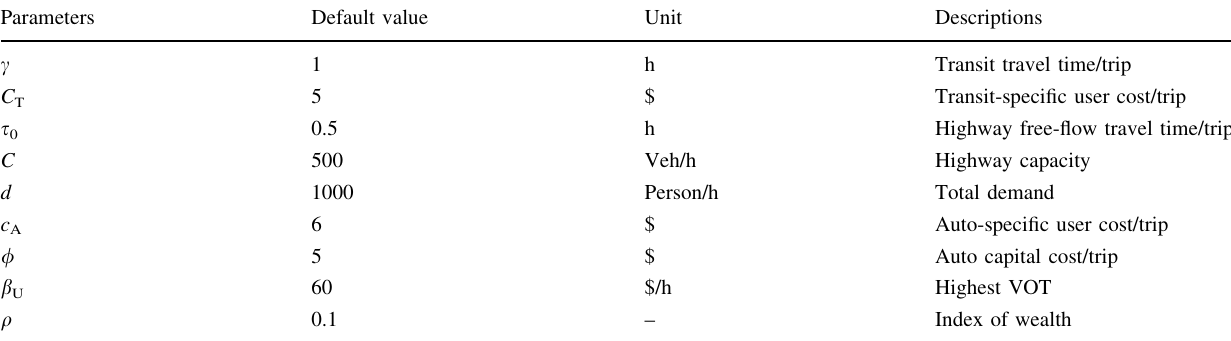
Table 1 Descriptions of model parameters [7] Parameters